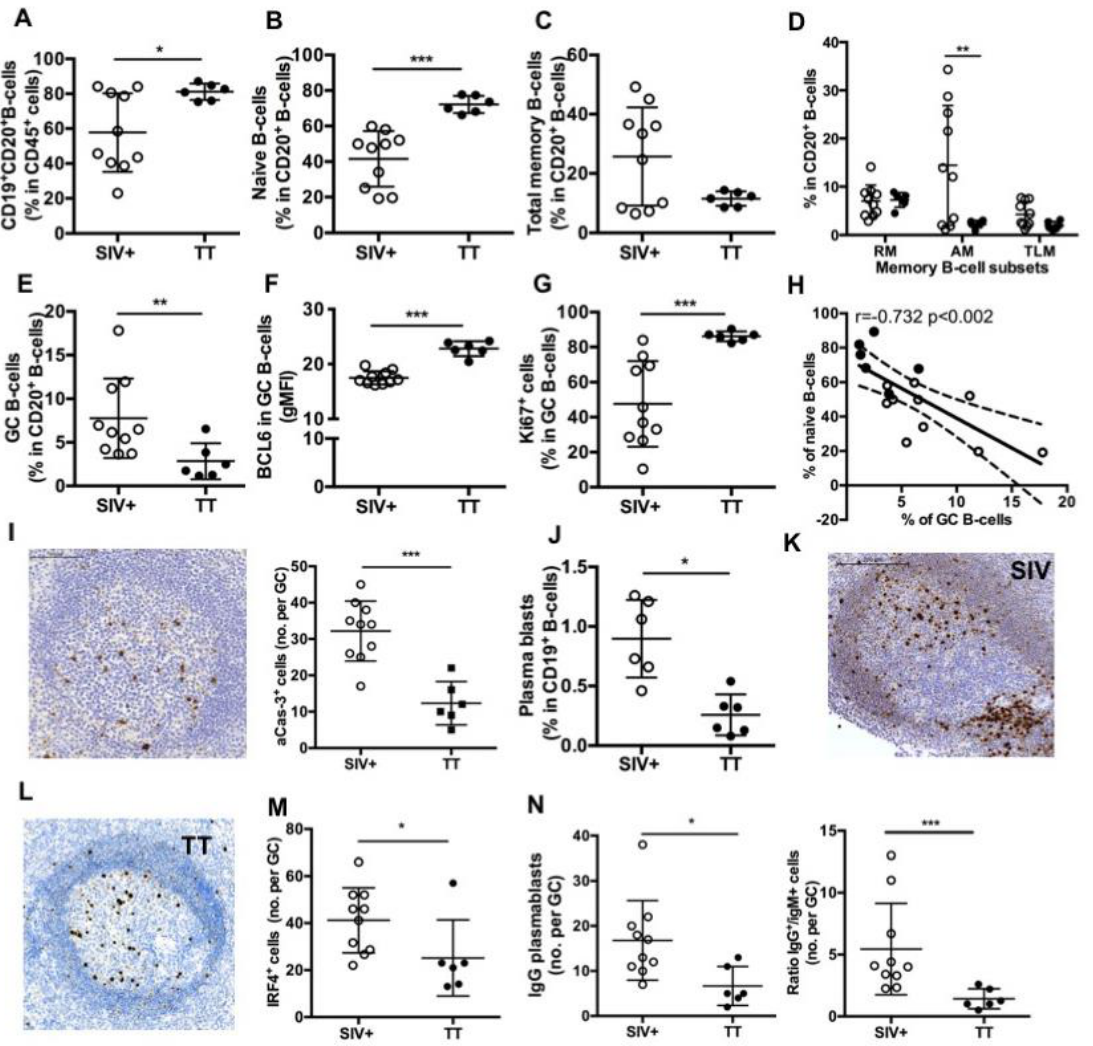
Figure 4. Splenic B-cell subsets in SIV-infected and TT-vaccinated macaques. ( A ) Proportions of CD19 + CD20 + B-cells in CD45 + cells as well as proportions of ( B ) naïve, ( C ) Total memory B-cells; ( D ) RM, AM and TLM B-cells; and ( E ) GC B-cells in CD20 + B-cells were determined by multi-parameter FCM for each macaque. ( F ) Intensity of Bcl-6 expression (gMFI) and ( G ) proportions of Ki67 + cells in GC B-cells are shown. ( H ) Graph represents the correlation between the percentages of GC and naïve B-cells. Spearman rank test was used for statistical analyses. rho and p values are given. ( I ) Representative staining with active-caspase-3 (aCas-3) Ab on section of one macaque from Group TT. Scale Bar = 200 µ m (left panel), graph represents the Mean number of aCas-3 + cells per GC for each macaque (right panel). ( J ) Proportions of plasma blasts (PBs) in CD19 + B-cells are shown. ( K , L ) Representative IRF4 staining on sections of one representative macaque from Groups ( K ) SIV + and ( L ) TT. Scale Bar = 200 µ m. ( M ) Graph represents the Mean number of IRF4 + cells per GC for each macaque. ( N ) Graph represents the Mean number of IgG + cells per GC for each macaque (left panel). Ratio between numbers of IgG and IgM PBs per GC was plotted for each macaque (right panel). In all panels, each dot represents one macaque from Groups SIV + ( open circle ) or TT ( black circle ). For all panels except ( H ), bars represent Mean ± SD. For all panels except ( D ) and ( H ), statistical comparison between groups was performed using Mann Whitney non-parametric test. For panel ( D ), statistical comparison between groups was performed using 2-way ANOVA with Bonferroni’s multiple comparisons test. Significant statistical values are indicated: * p < 0.05 , ** p < 0.01 and *** p < 0.001 .